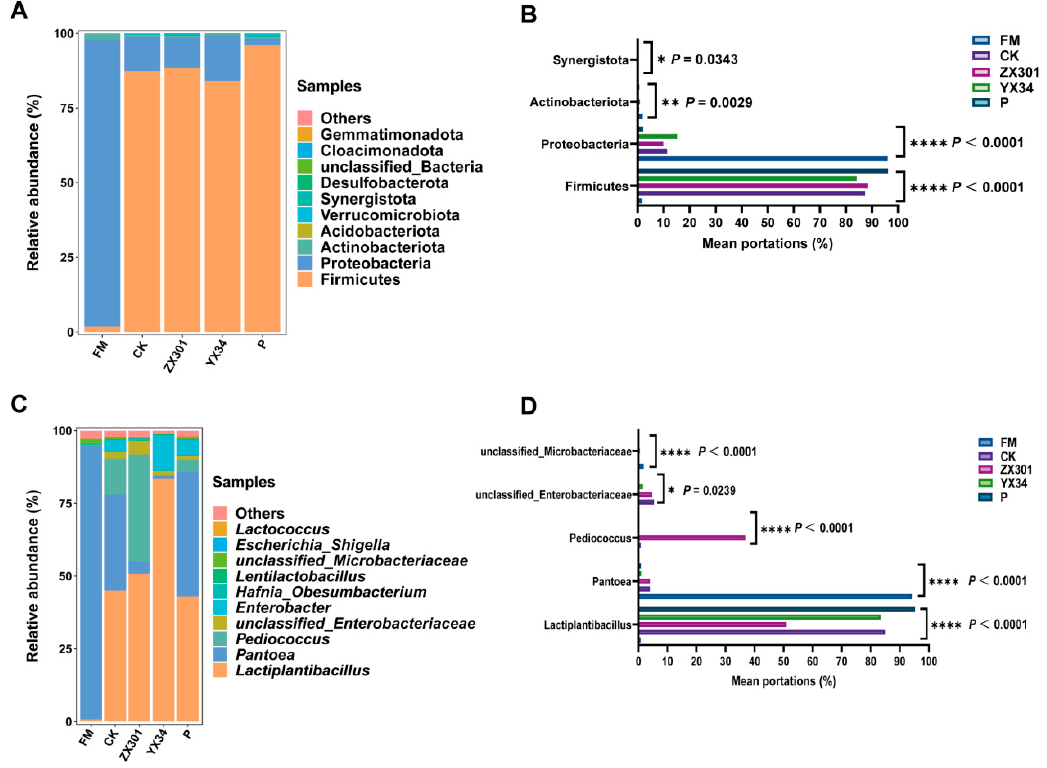
Figure 2. The bacterial community of FM and Stipa grandis on 60 days of ensiling ( n = 3): ( A ) The bacterial community was shown at the phylum level. ( B ) The extended error bar plot displaying the significant differences among groups at the phylum level ( C ). The bacterial community was shown at the genus level. ( D ) The extended error bar plot displaying significant differences among groups at the genus level. Levels of significance are shown as follows: * p < 0.05; ** p < 0.01; **** p < 0.0001. FM, fresh matter; CK, control group; ZX301, pediococcus pentosaceus -treated group; YX34, lactobacillus planturum -treated group; P, a commercial inoculant-treated group containing lactobacillus plantarum .